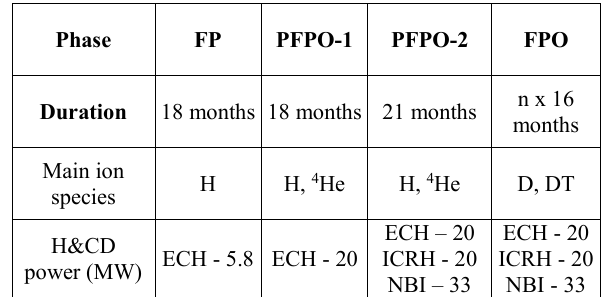
Table 1. The four stage approach of the ITER Research Plan; for First Plasma the duration includes Integrated Commissioning (11 months), First Plasma operation (1 month) and Engineering Operation (6 months).